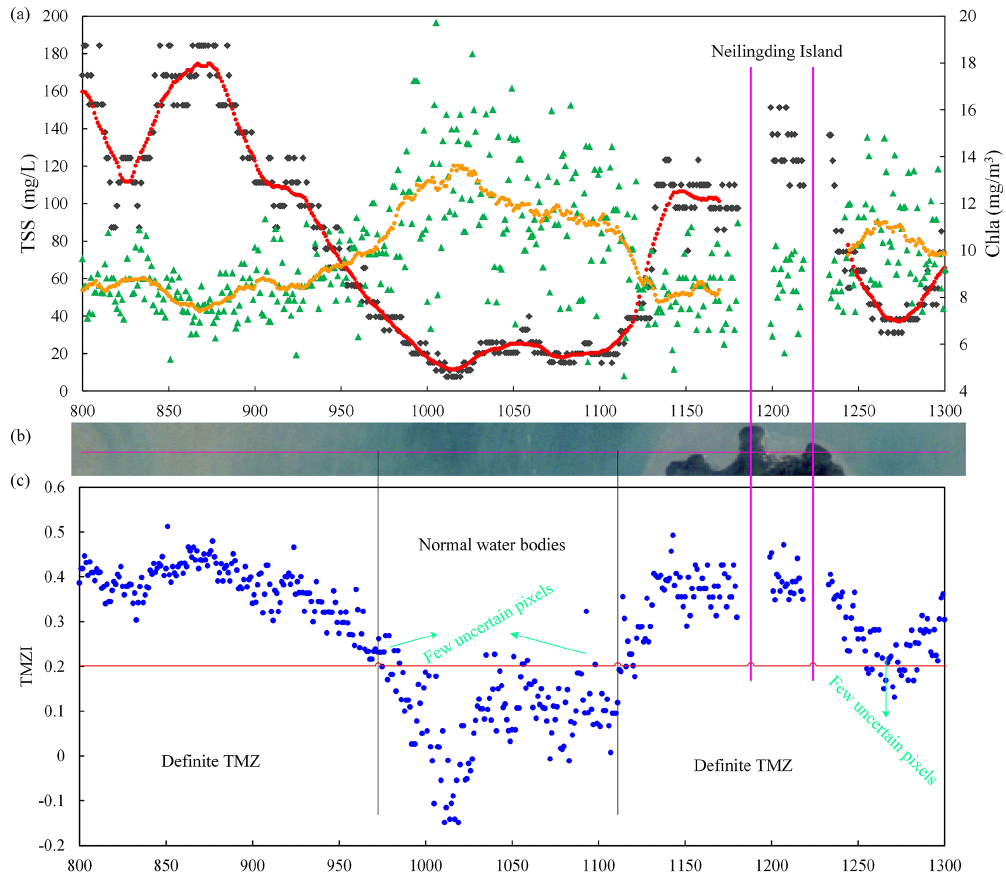
Figure 5. The corresponding spatial relationship between the TSS concentrations, indicated by black dots and red trend line, and Chl a concentrations, indicated by green triangles and orange trend line of row 1600 (a) , the true color imagery (b) , and the corresponding values of the TMZI (c)